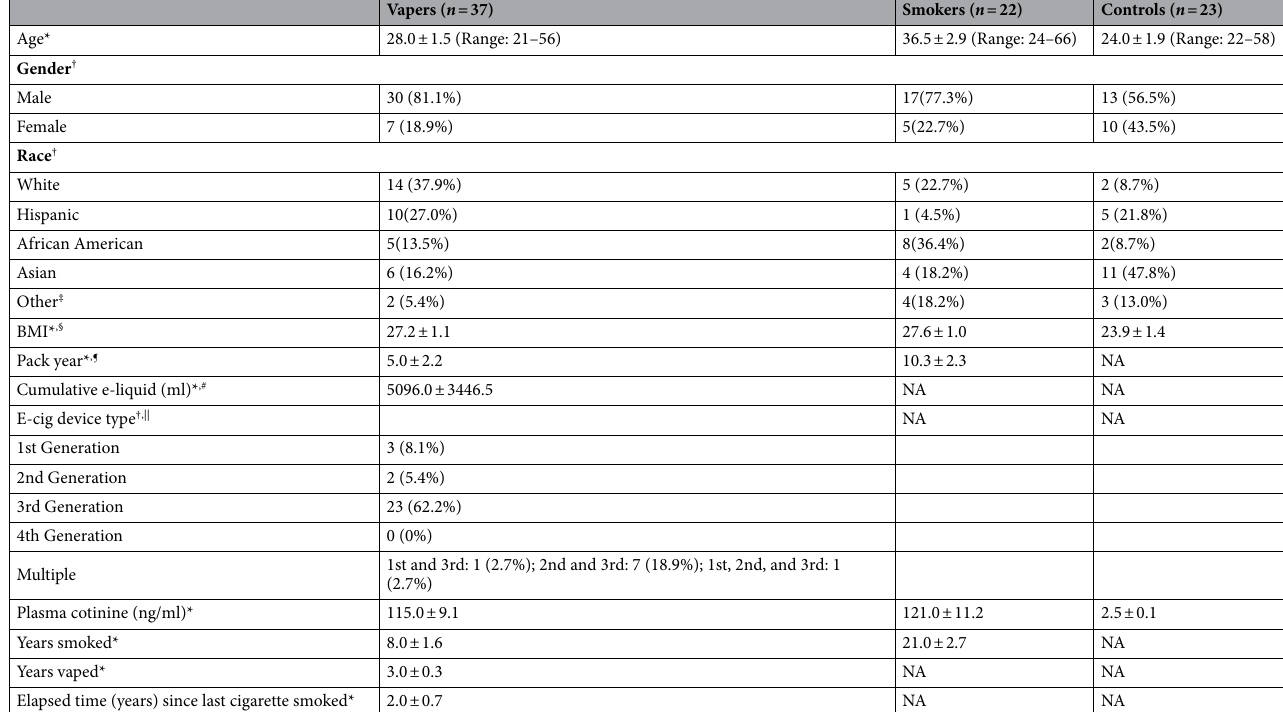
Table 2. Characteristics of the study population. NA not applicable. *Results are expressed as Median ± SE. † Numbers and percentages (inside brackets) are indicated. ‡ Other = Multiracial or Native American. § BMI: Body Mass Index [Weight (kg) ÷ Height 2 (m) ]. ¶ Pack Year is calculated by multiplying the number of packs